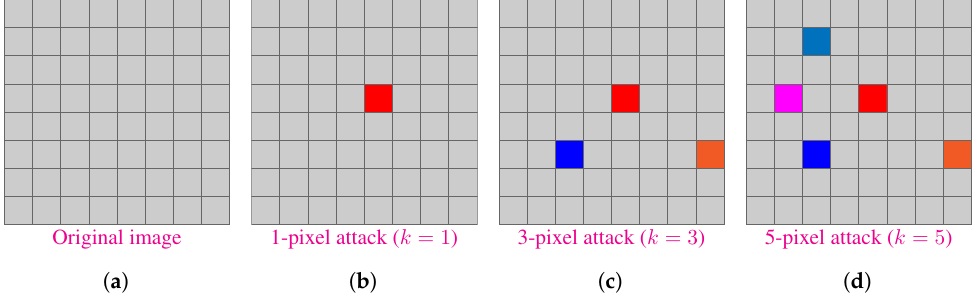
Figure 4. Illustration of k -pixel perturbation technique for attacking a CNN. It shows a image with a grid of 8 × 8 pixels. ( a ) Original Image, ( b ) k = 1, ( c ) k = 3, and ( d ) k = 5. A pixel is assigned a random RGB value for